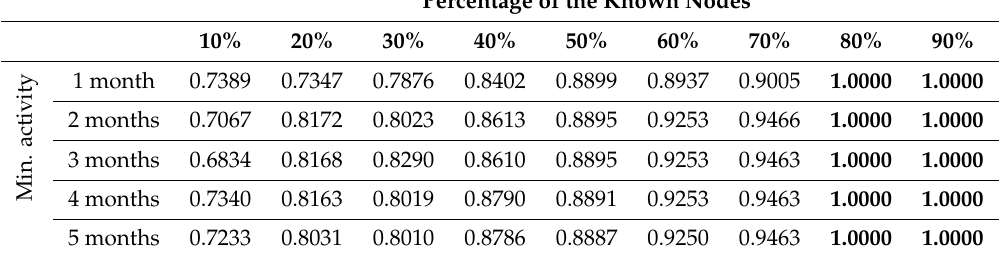
Table A5. F-score macro average for the collective classification of two levels of the hierarchy in the manufacturing company dataset. The values which are bolded are the best results for a given minimum communication activity.